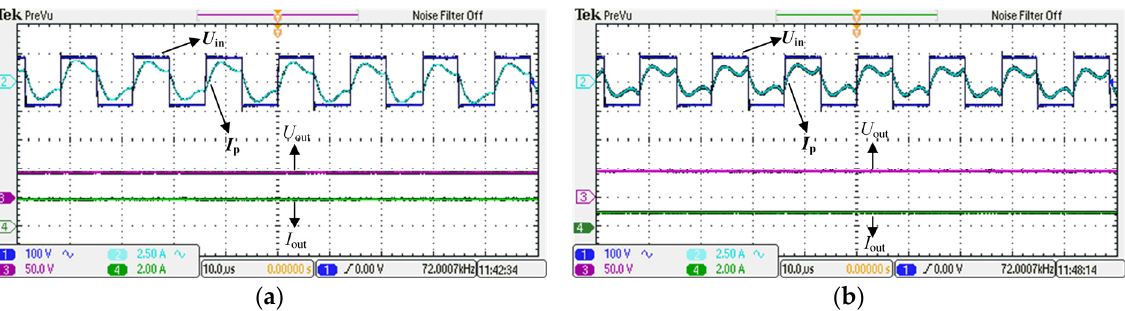
Figure 14. Experimental waveforms of the IPT system in CV charging mode. ( a ) R L = 25 Ω ; ( b ) R L = 50 Ω .